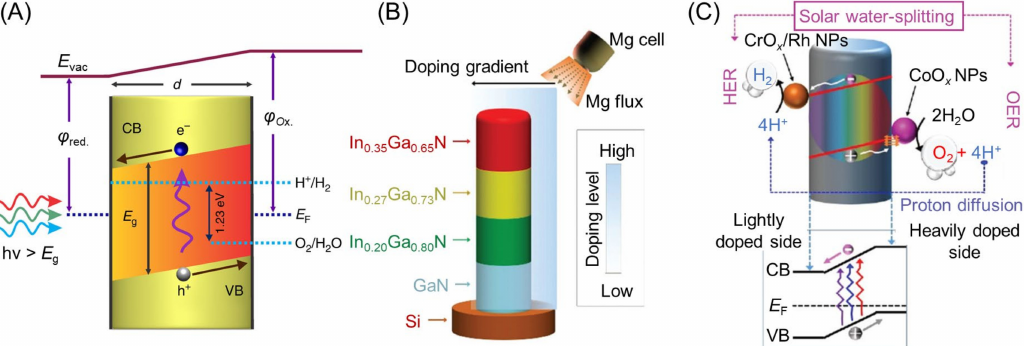
Figure 41. ( A ) Structural and optical properties of InGaN photochemical diode. Energy-band representation of the proposed photochemical diode (PCD) with radial thickness “ d ” showing the built-in electric field (band-bending) that separates the excitons (electron and hole) and drives them towards the opposite cathode and anode surfaces. In contrast to a conventional p–n PCD, only a single photon absorption is required to generate one active electron–hole pair to participate in the redox reaction (such as a Schottky-type photochemical diode). ( B ) Schematic of the quadruple-band InGaN nanowire. The p-type dopant originating from the tilted Mg effusion cell (relative to the nanowire orientation) leads to the Mg-doping gradient profile in the lateral direction of the